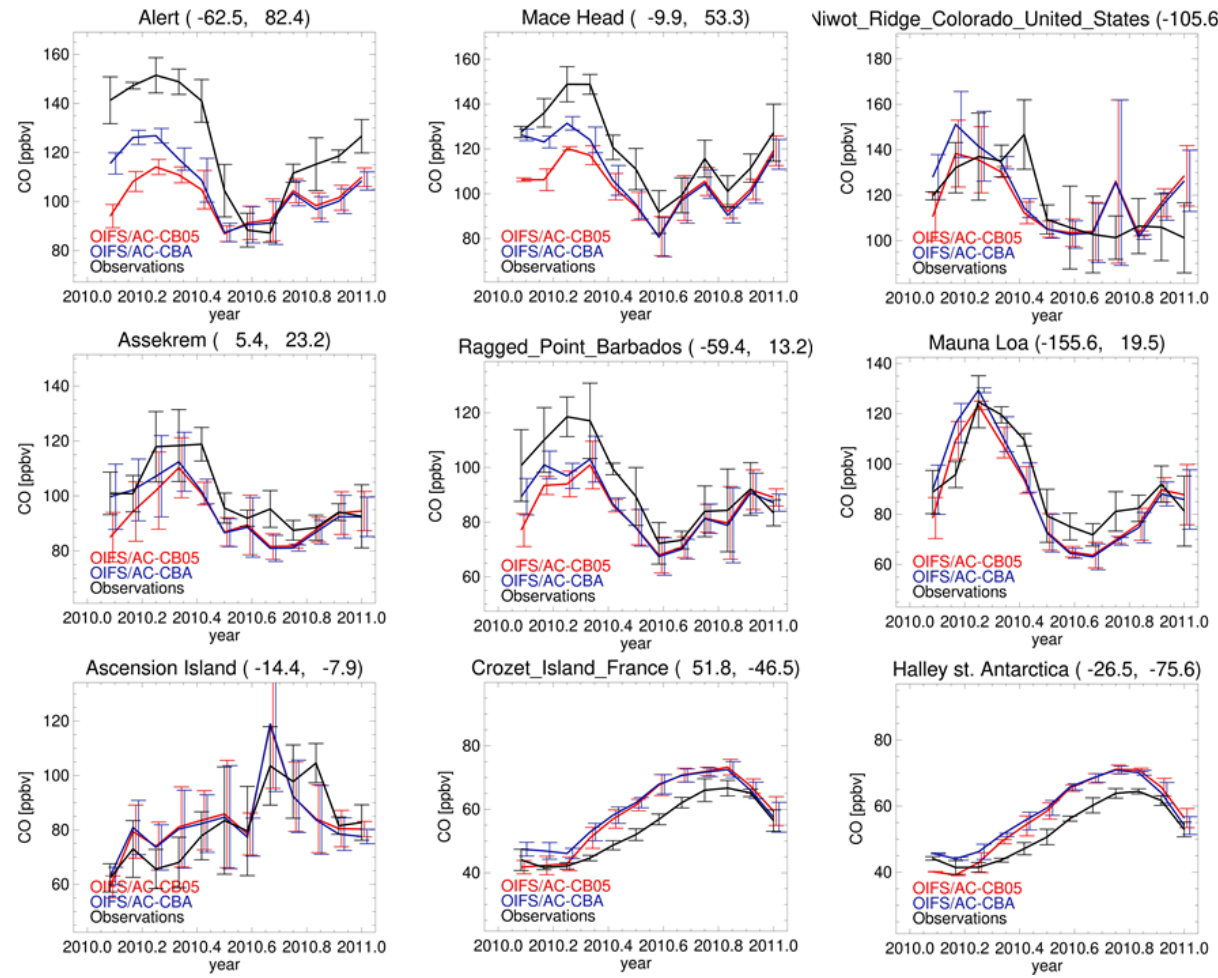
Figure 6. Evaluation of OpenIFS/AC carbon monoxide mixing ratios at the surface against NOAA ESRL flask observations.